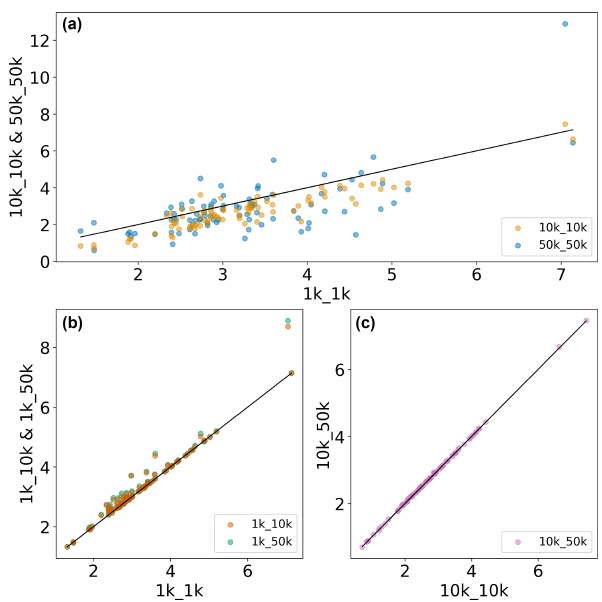
Figure 6. Scatterplot of RRMSE values obtained in the evaluation of simulated upper soil moisture with ESA-CCI data for (a) com- paring different model resolutions, (b) comparing different forcing resolutions for 1K runs, and (c) comparing different forcing resolu- tions for 10K runs.